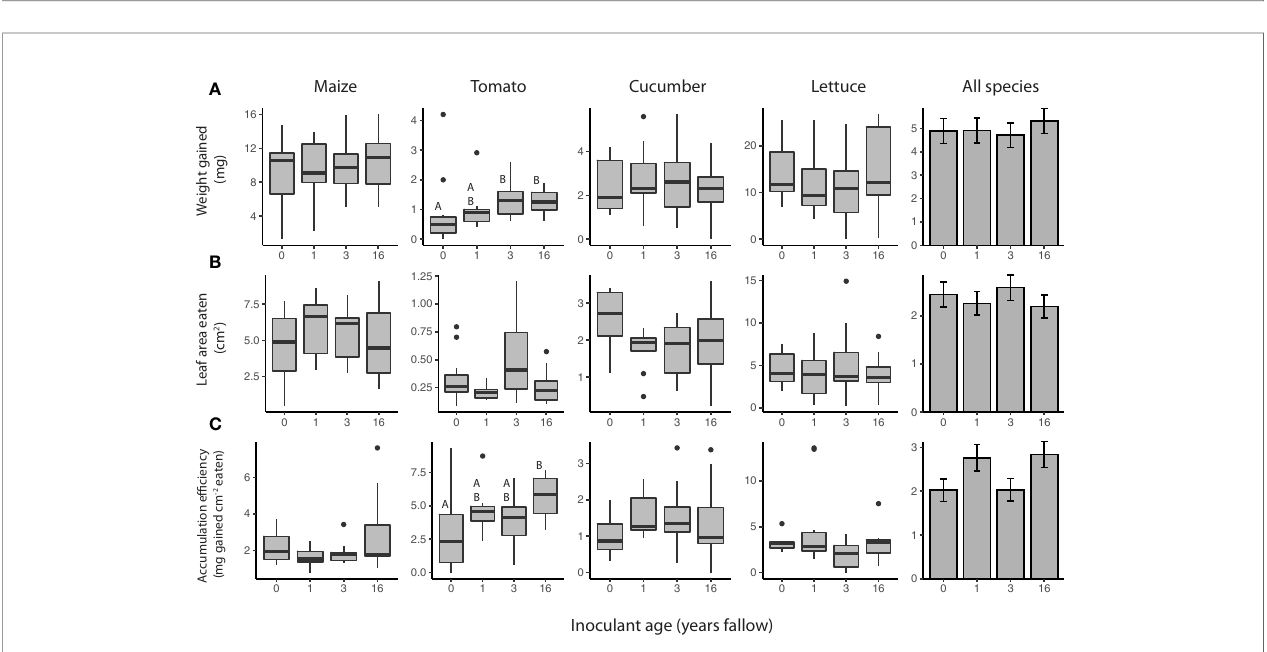
FIGURE 4 | Spodoptera frugiperda resistance of maize ( Z. mays ), tomato ( S. lycopersicum ), cucumber ( C. sativus ), and lettuce ( L. sativa ) plants inoculated with agricultural (0 year) or fallow microbiomes of different ages (1, 3, or 16 years post-agriculture) in a no-choice assay. Resistance measured as (A) weight gained (B) amount of tissue eaten by S. frugiperda larvae ( c. 6 d old at start), as well as their (C) biomass accumulation ef fi ciency after feeding for 3 (maize, tomato, and cucumber assays) or 4 d (lettuce assays). N = 8-12 replicates per species × inoculant age treatment after omitting insects that died. Boxes enclose the middle 50% of values, with the 50 th percentile indicated by the midline and error bars spanning 1.5 times the interquartile range in both directions; values outside this range are indicated as black dots. Bar plots show estimated marginal means (± SE) averaged across species, and inoculant and greenhouse spatial blocks (see model outputs in Table 3 ). Letters above the boxes indicate signi fi cant differences between inoculant age levels within plant species ( a =